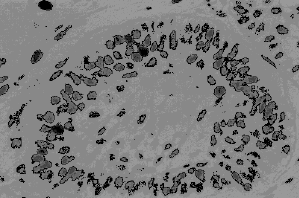
Fig. 3. PCNA expression in follicular pattern of ameloblastoma. Positive nuclei for PC10 are predominantly found in the peripheral cells. Some nuclei of central cells are positive for PC10. ABC method with methyl green counterstain, × 135.